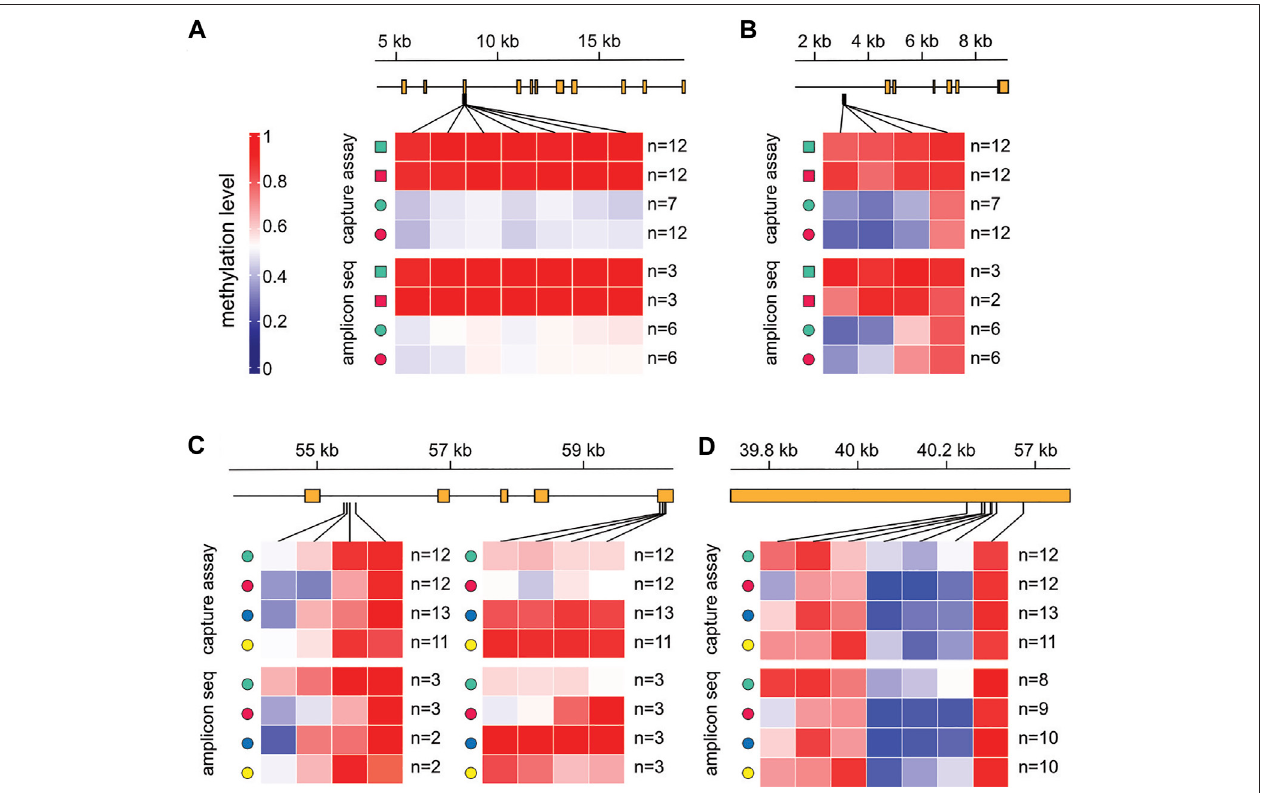
FIGURE 5 | Validation of location-dependent differential methylation in marbled cray fi sh. Results are shown for capture-based sequencing and for the corresponding validation experiment with amplicon sequencing, for four different genomic regions. (A) scaffold 139,595: 4,000 – 19,145; (B) scaffold 220,173: 1,241 – 9,258; (C) scaffold 10,188:54,147 – 60,918; (D) scaffold 195,460: 39,668 – 40,474. Squares: abdominal muscle; circles: hepatopancreas; green: Reilingen; red: Singlis; blue: Andragnaroa; yellow: Ihosy.